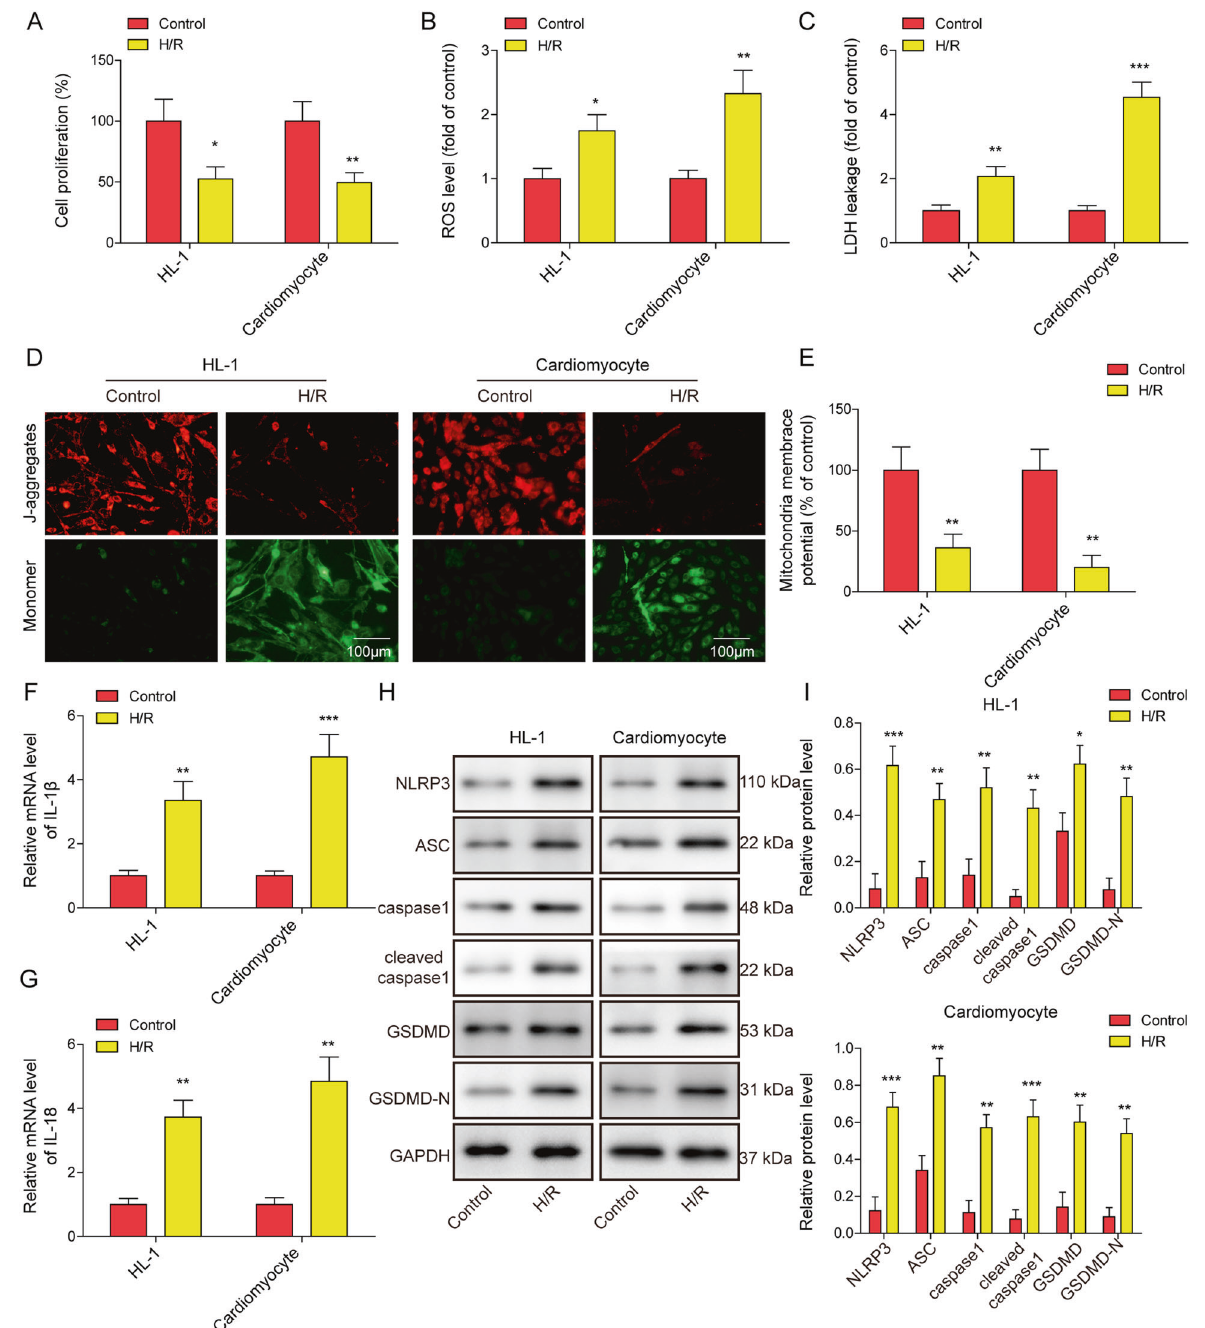
Fig. 1 H/R treatment led to mitochondrial dysfunction and pyroptosis in cardiomyocytes. HL-1 and primary mouse cardiomyocytes were treated with H/R for 24 h. A Cell proliferation ability was measured using a CCK-8 assay. B ROS levels were measured using a DHE assay. C LDH levels were measured using an LDH assay kit. D , E Mitochondrial membrane potential was evaluated using JC-1 staining. F IL-1 β and G IL-18 mRNA levels were assessed using qRT-PCR. H , I Western blot analysis determined the expression levels of pyroptosis-related markers. * P < 0.05, ** P < 0.01 and *** P < 0.001. I/R treatment-induced myocardial damage was reduced by NAC inhibited the H/R-induced increase in IL-1 β and IL-18 and the silencing TUG1 in an in vivo mouse model expression of pyroptosis-related proteins, including NLRP3, We then continued to validate our hypothesis in in vivo mouse caspase-1, ASC, GSDMD, cleaved caspase-1, and cleaved GSDMD models. TTC staining results indicated an increased MI area in the I/R (Fig. 6C – F), and cotreatment with NAC in TUG1-silenced cardio- group compared to the control group (sham), while silencing TUG1 myocytes showed lower levels of those factors than NAC reduced the MI area o (Fig. 7A, B). H&E staining showed damaged treatment or TUG1 silencing alone. These results indicate that cardiac structures and signi fi cant cell death in the I/R group, and the ROS play key roles in promoting pyroptosis in H/R-treated cardiac damage in the I/R + shTUG1 group was partially relieved cardiomyocytes.